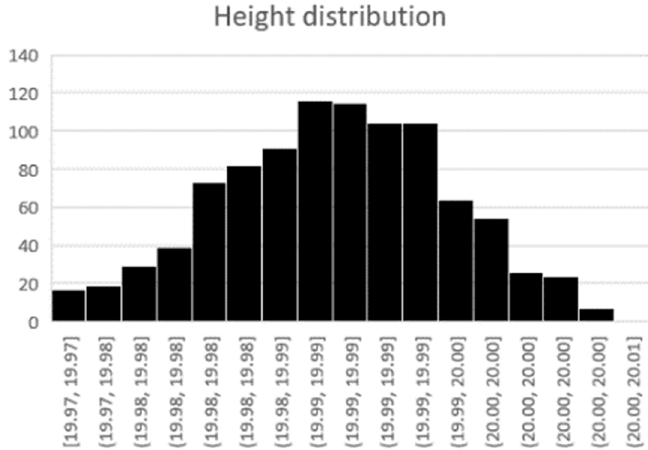
Figure 10. Histogram of height.